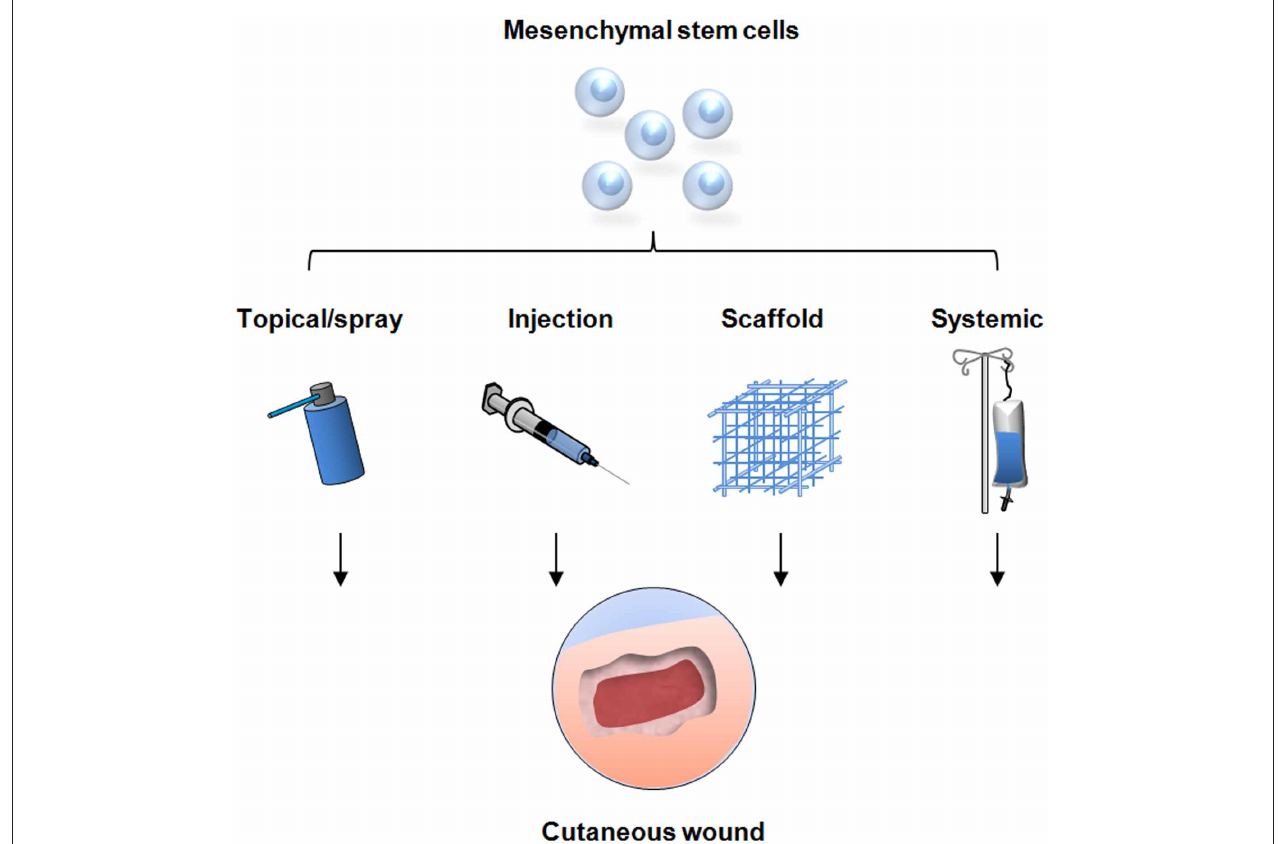
FIGURE 2 | Strategies for mesenchymal stem cell delivery to cutaneous wounds. Traditional techniques include local injection of cells into the soft tissue, direct topical application, and systemic delivery via injection into the peripheral circulation. These methods have resulted in improved wound